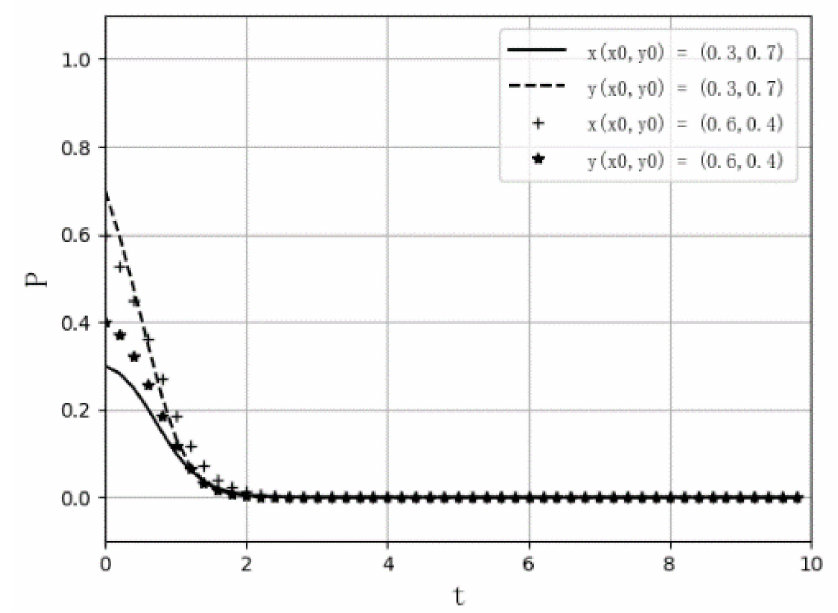
Figure 9. Path diagram of the evolutionary game of Scenario 3 (I 2 + B < I 3 + R 2 − F, G 1 − G 2 >